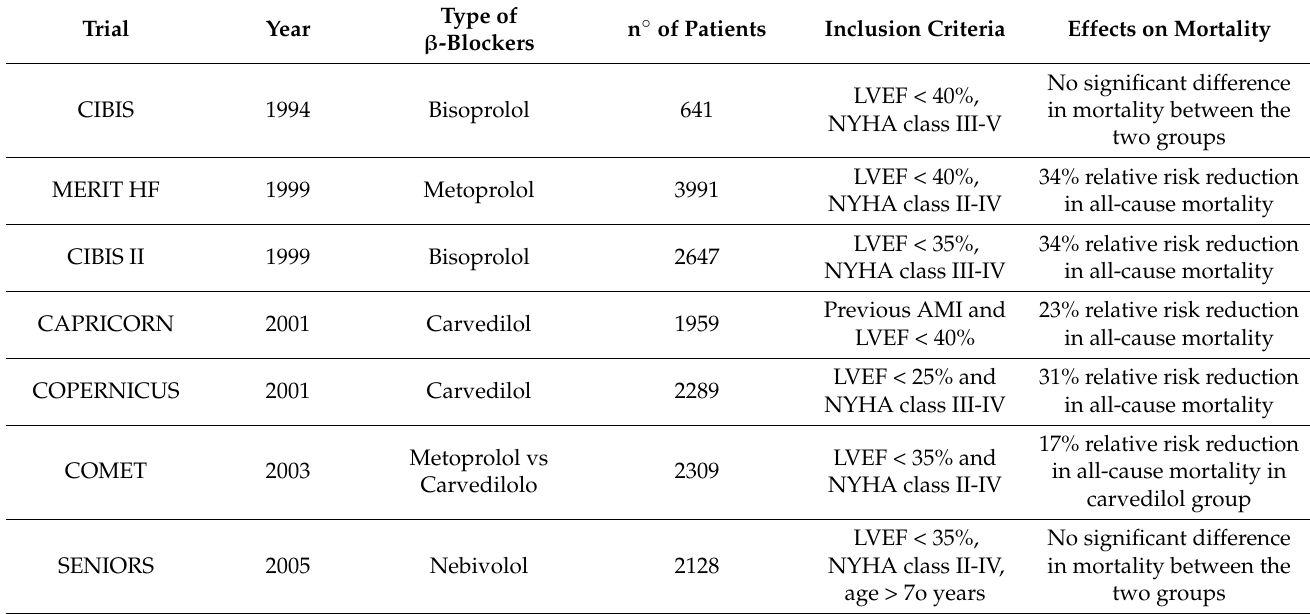
Table 2. Summary of randomized control clinical trials in heart failure with reduced ejection fraction. LVEF: left ventricular ejection fraction, NYHA: New York Health